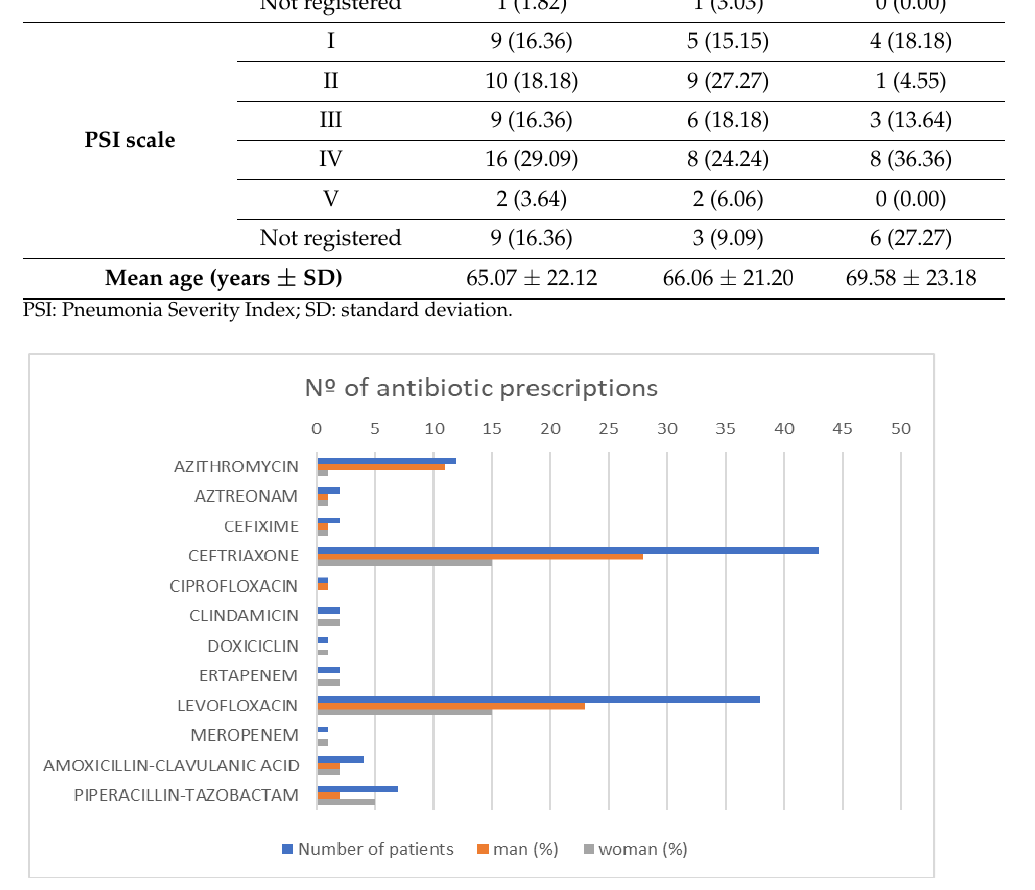
Figure 1. The number of antibiotics